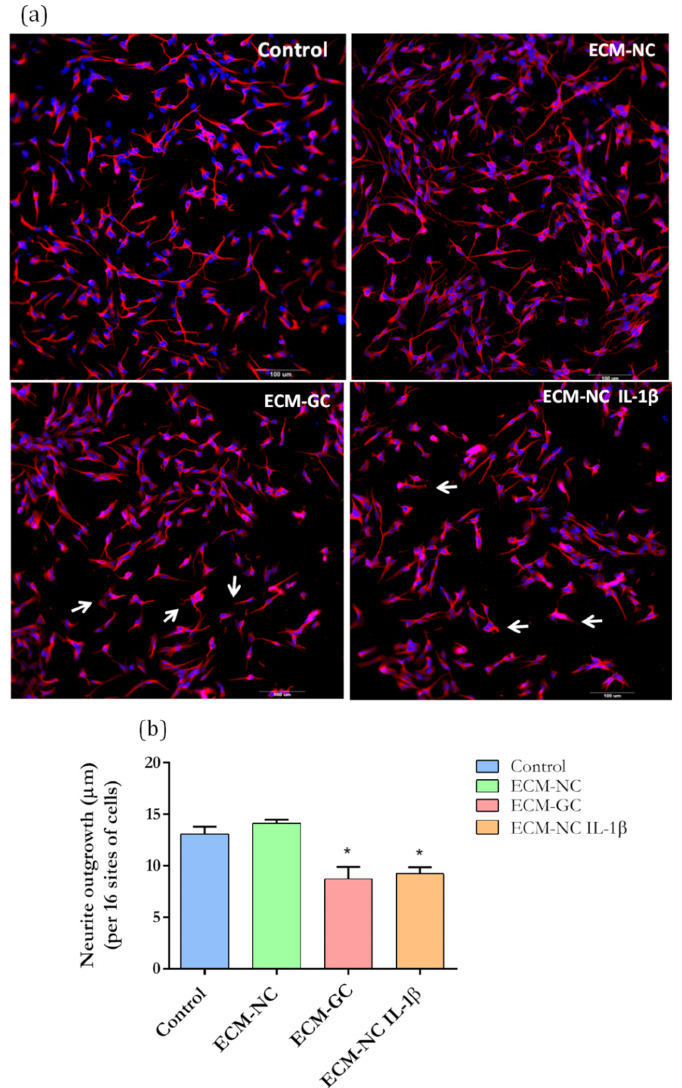
Figure 10. ( a ) Representative images of immunofluorescence show neurite length in sensory neuron- like cells. Arrows represent the reduced neuron interconnection and retraction of neurons outgrowth. ( b ) Quantification of neurite length in neuron-like cells based on β -III tubulin immunostaining. Data from 72 h of incubation. Magnification 20 × . Scale bar: 100 µ m. Data were analyzed by t -test (* p < 0.05 different from control), ECM-NC (normal collagen), ECM-GC (glycated collagen). Three independent and similar assays were performed in